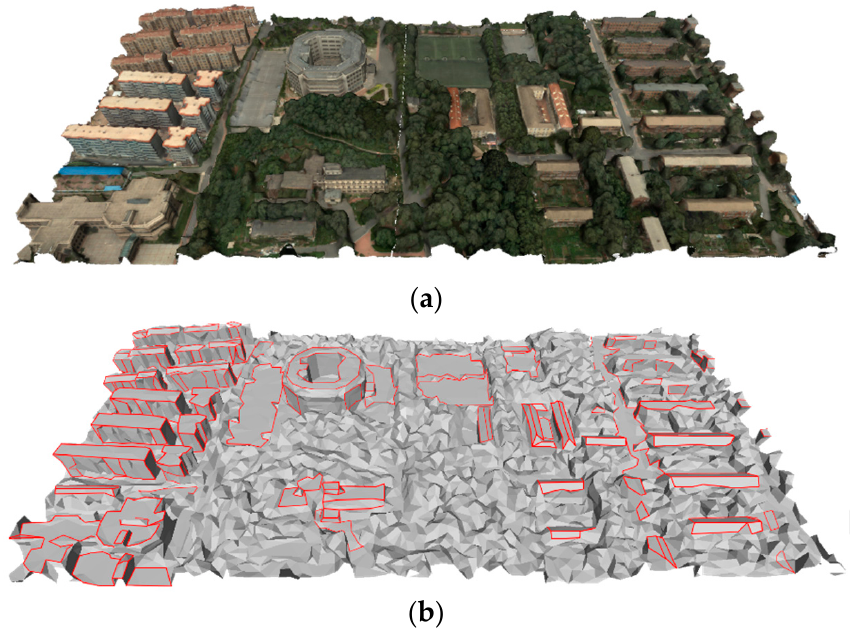
Figure 10. ( a ) Input surfaces with texture; ( b ) sub-planar edges (red borders) extracted with 0.9 simplification by QSlim. Sub-planar edges are approximately consistent with our subjected image of urban infrastructure.